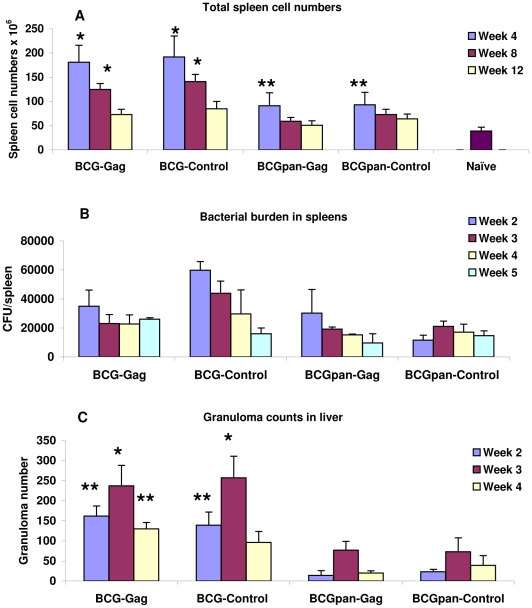
Cellular responses to BCG-Gag and BCGpan-Gag.Groups of mice were vaccinated with BCG-Gag, BCG-Control, BCGpan-Gag or BCGpan-Control (107 cfu, i.p.). (A) Total cell numbers in spleens harvested at the indicated times. Bars are mean total spleen cell numbers and standard deviation of the mean for 10 mice per vaccine. Value for naive mice (unvaccinated) is also indicated. (B) Bacterial burden at the indicated times determined by growth (3 weeks, 37°C) of spleen homogenates on 7H10 medium with kanamycin and also with pantothenate for the BCGΔpanCD strain. Bars are mean CFU per spleen and standard deviation of the mean for 3 mice per vaccine. (C) Quantitative analysis of liver granuloma formation 3 weeks after infection. Bars are the mean and standard deviation of the mean of microscopic counts for 3 mice per vaccine. Counts are from 10 fields per liver section with magnification 100×. This corresponds to 1 mm2 per field, total 10 mm2, which is approximately the total area of a liver. Asterisks indicate (A) statistical significance compared to naive mice, or (C) compared to ΔpanCD strain (C); *<0.01; **<0.05; Student's t-test for unpaired data.